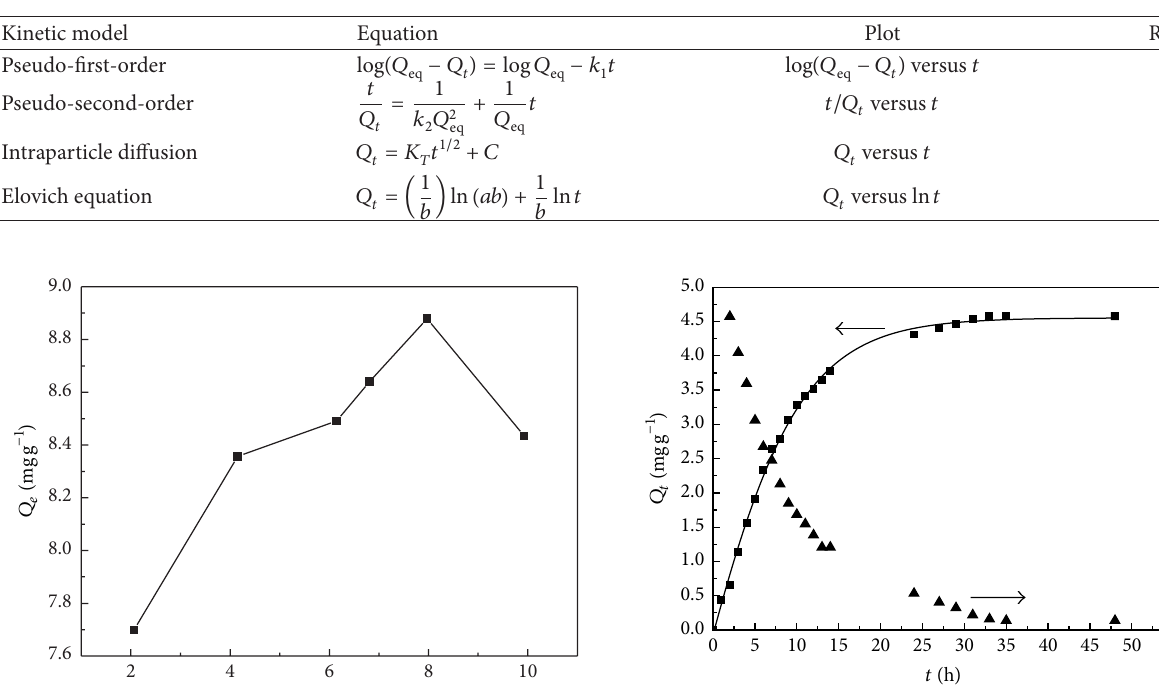
Figure 8: The surface morphology of the nanocomposite particles ((a) AC1; (b) AC2; (c) AC3). Table 1: Kinetic models and their equations.